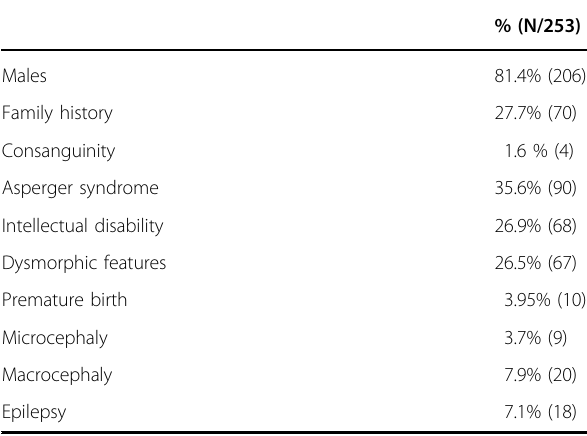
Table 1 Demographic and phenotypic characteristics of the